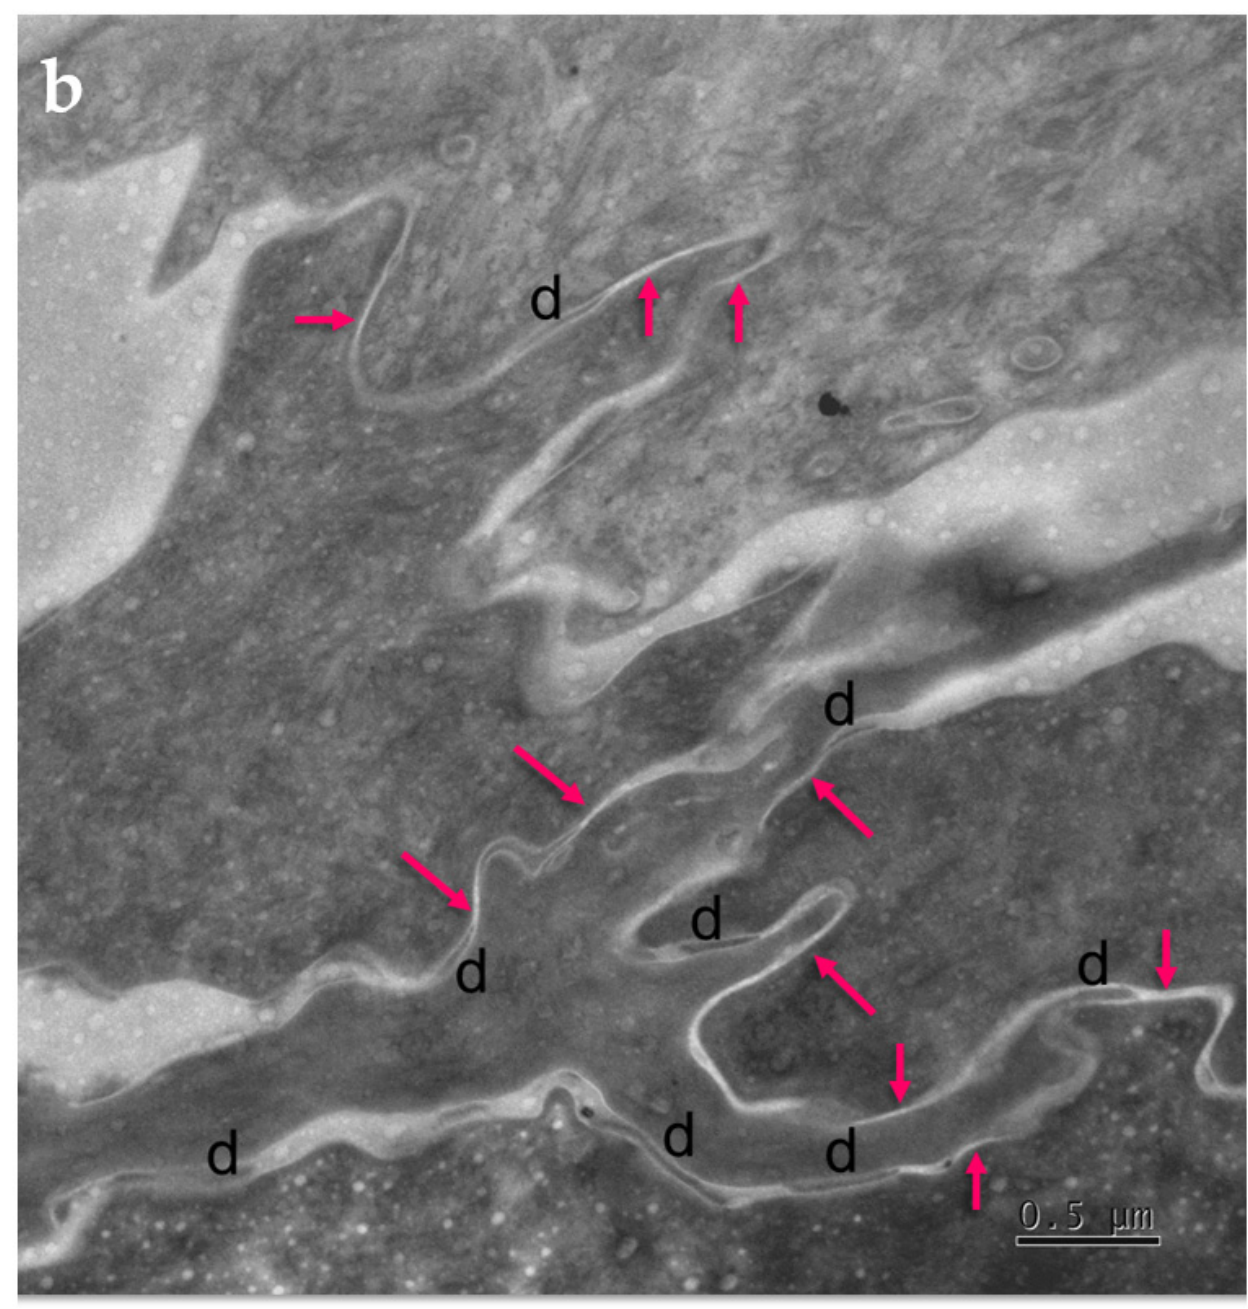
Figure 4. Ultrastructural features observed in the SC of PSD include paucity of corneodesmosomes (d) that rapidly disappear from the lower parts of the horny layer, as seen in ( a ), and upregulation of expression of TJ-derived intercorneocyte “fusions” (arrows). ( b ) In the upper SC, the remaining corneodesmosomes (d) are often found in the proximity of the TJ-derived riveting structures (arrows). Bars = 1 µm in ( a ); 0.5 µm in ( b ). Table 4 . Fraction of the apical-lateral contacts between corneocytes showing “fused” morphology in the SC of PSD. NHS = normal human skin.